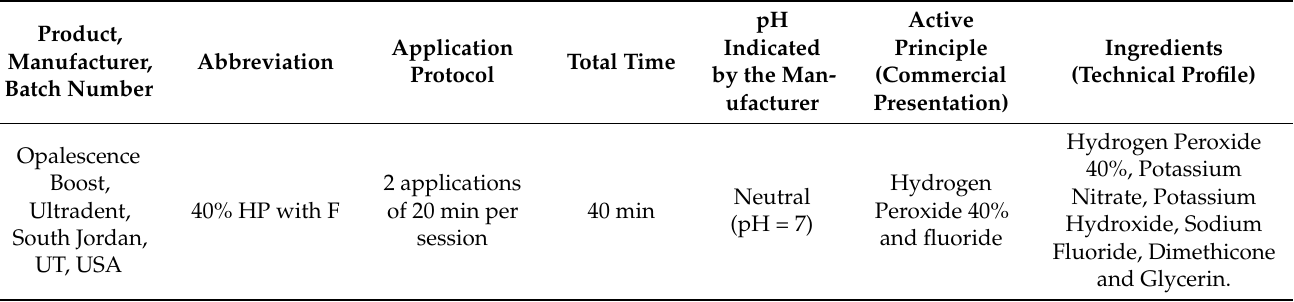
Table 1. Bleaching gels used in this